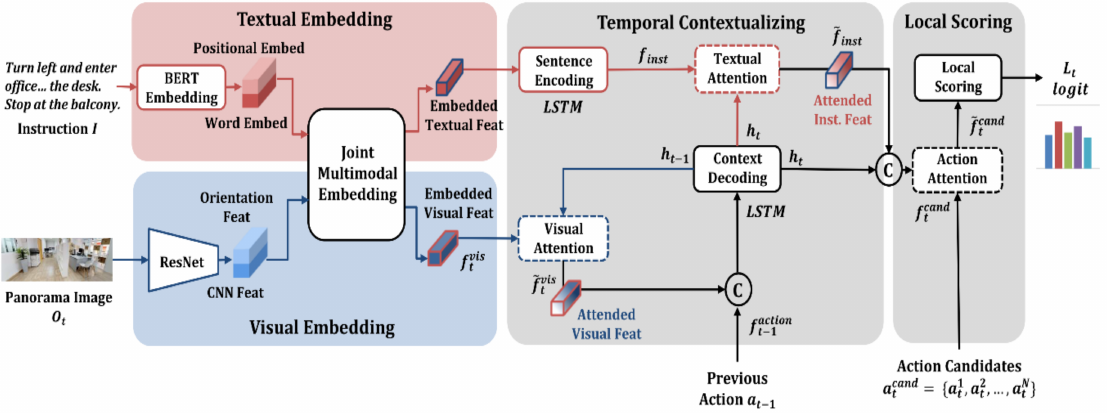
Figure 4. Architecture of local scoring network.